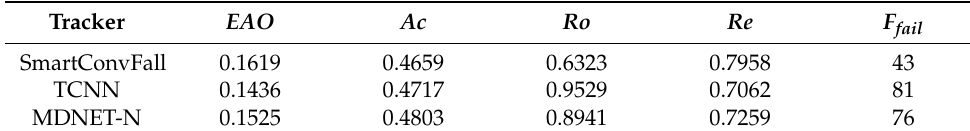
Table 12. Performance comparison of each tracker for no attribute-based videos.